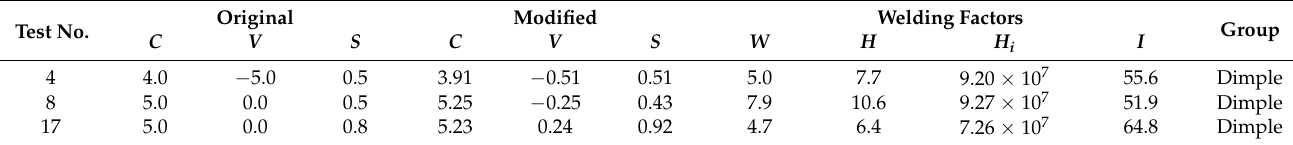
Table 14. Results of welding parameters modified by the optimization process.